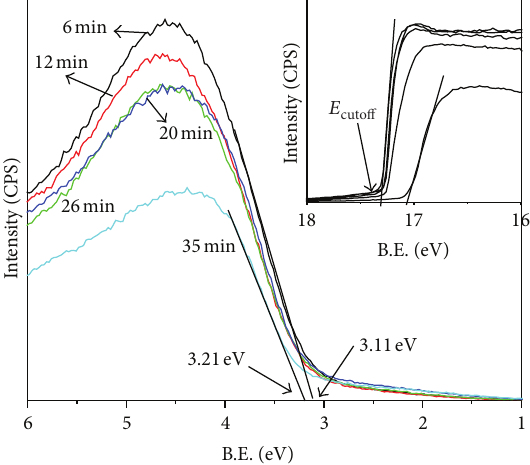
F 7: e �PS spectra of ITO/�nO thin